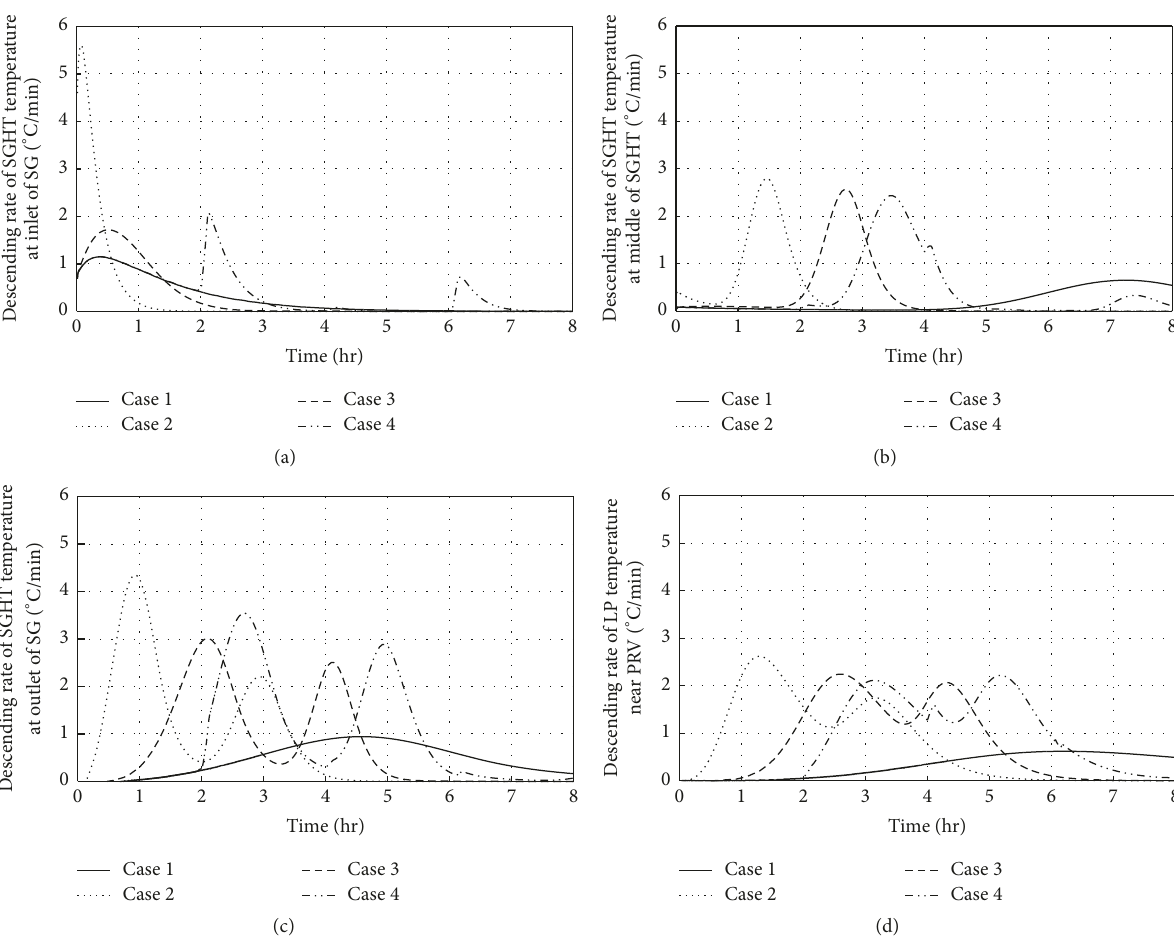
Figure 8: Temperature descending rate at different locations during precooling